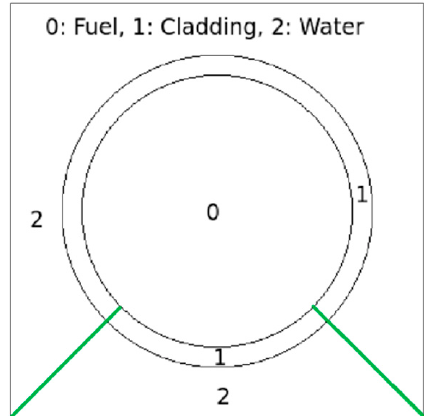
Figure 2. Construction of fuel pin cell with legend of the materials and the numbering of meta- cells.